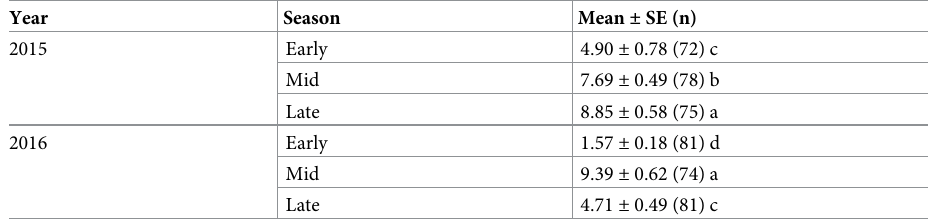
Table 4. Density of spiders per pitfall trap early, mid, and late season in 2015 and 2016.